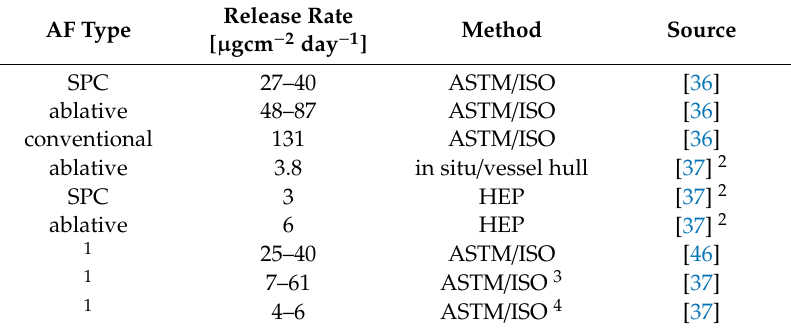
Table 2. Available copper emission results.